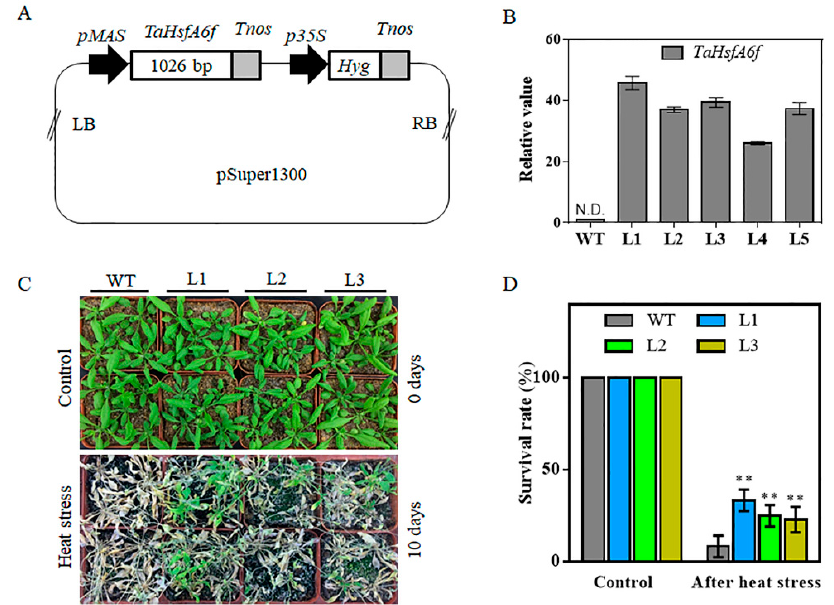
Figure 3. Thermotolerance of WT and transgenic Arabidopsis plants. ( A ) Schematic representation of the construct used for Arabidopsis transformation. LB left border, pMAS mannopine synthase promoter, Tnos nopaline synthase gene (NOS) terminator, Hyg Hygromycin-resistance gene, RB right border. ( B ) Relative expression levels of TaHsfA6f in the leaves of T3 transgenic Arabidopsis lines via qPCR analysis. Each value is the mean of triplicate experiments. Bars indicate standard deviations. WT wild-type, N.D = Not Detected. ( C ) Comparison of thermotolerance among WT and three transgenic lines (L1, L2, and L3). ( D ) Survival rates of WT and three transgenic lines after heat stress at 40 / 32 ◦ C (day / night) for 10 days. For each experiment, 20 plants per line were used; values are means ± SD from three independent measurements (** p < 0.01 by Student’s t -test).